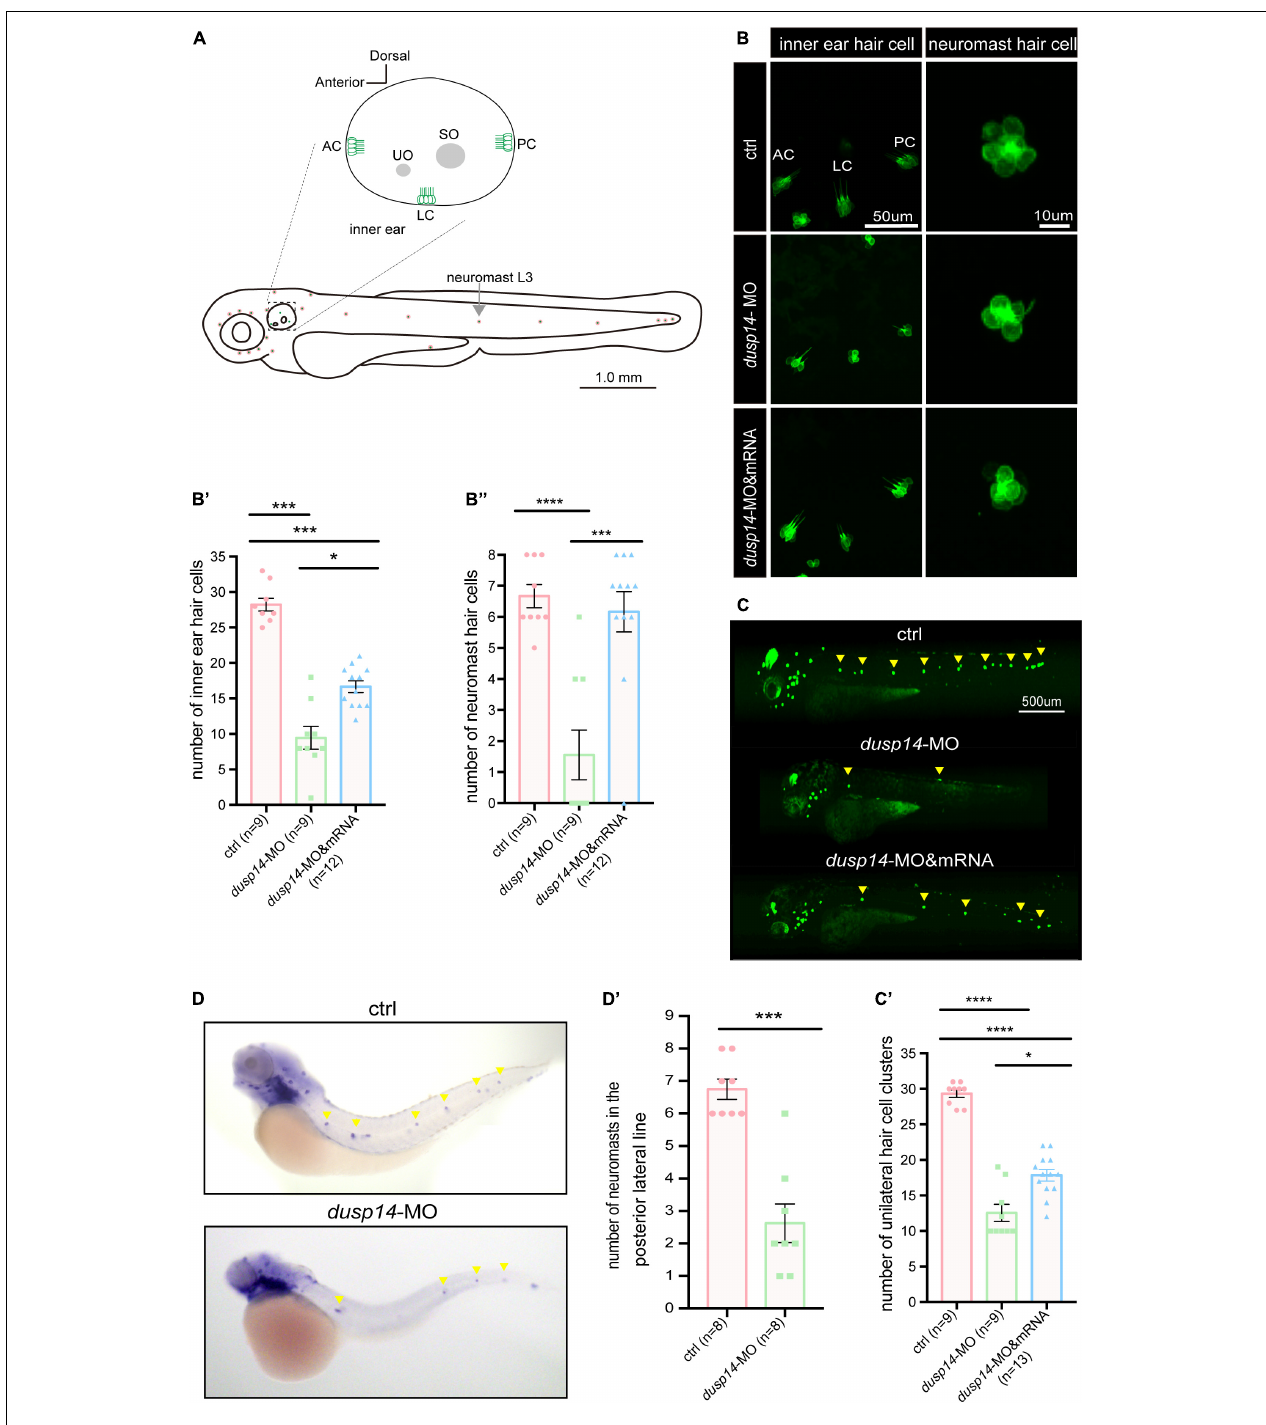
FIGURE 3 | Knockdown dusp14 expression by morpholino decreases the number of hair cell and neuromasts in zebrafish. (A) Schematic diagram of zebrafish neuromast and inner ear hair cell. (B) Confocal imaging analysis of crista hair cells in the otic vesicle of control and dusp14 deficiency zebrafish at 72 hpf. (B (cid:48) ) The statistical analysis of the numbers of inner ear crista hair cells in the control and dusp14 morphants at 72 hpf. (B (cid:48)(cid:48) ) The statistical analysis of the numbers of hair cells in the remaining neuromast L3 in the control and dusp14 morphants at 72 hpf. (C) The imaging analysis of control and dusp14 morphants at 72 hpf in fluorescent field. Scale bar = 500 µ m. (C (cid:48) ) Quantification of the number of unilateral hair cell clusters of control and dusp14 morphants at 72 hpf. (D) in situ hybridization of the eya1 gene specifically expressed in the neuromasts showed that the number of neuromasts in dusp14 -MO zebrafish was decreased. (D (cid:48) ) statistics results of D. Each bar represents the mean ± SEM. Values with *, ***, and **** above the bars are significantly different ( P < 0.05, P < 0.001, and P < 0.0001, respectively).